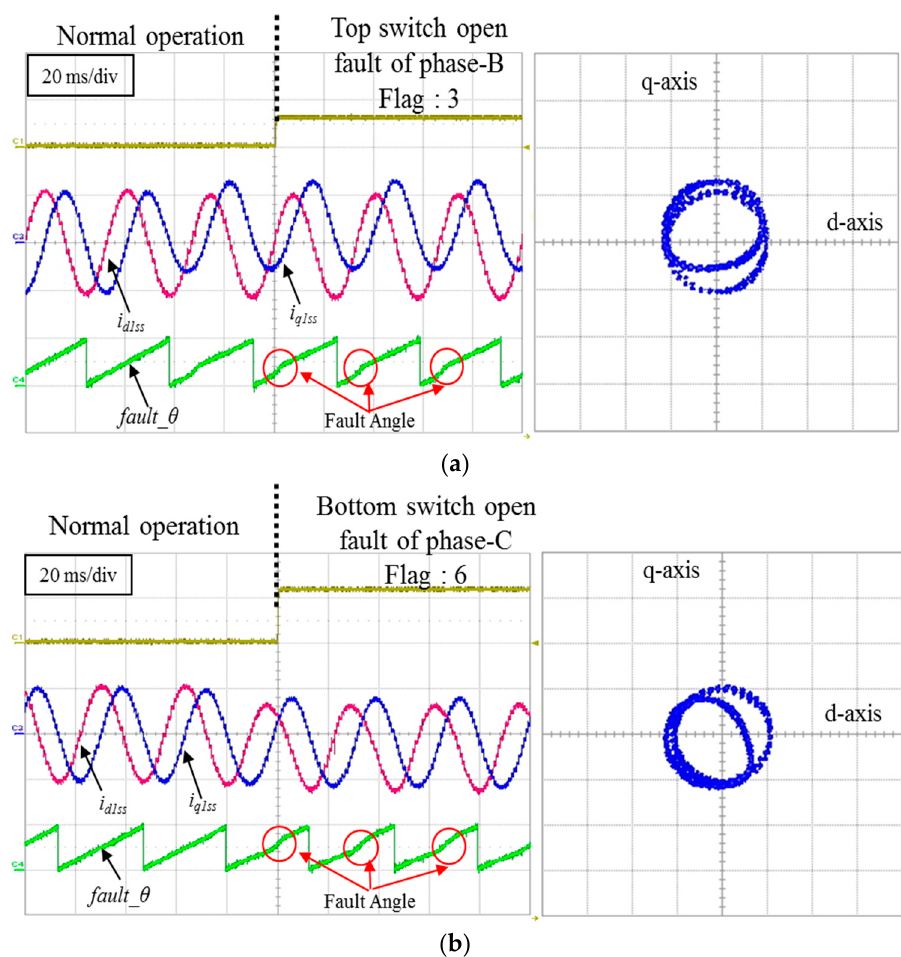
Figure 9. Experimental result of fault detection method about fault_ θ : ( a ) Top switch of phase B; ( b ) Bottom switch of phase C.